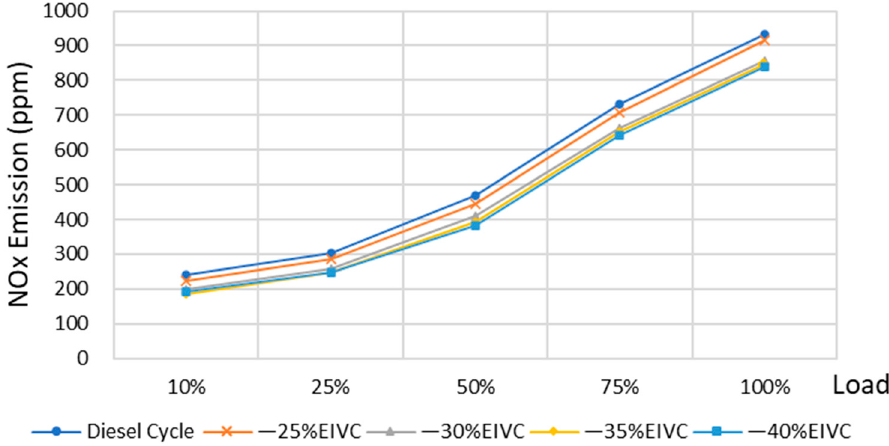
Figure 6. Comparison of NOx emission under diesel engine EIVC Miller cycle.